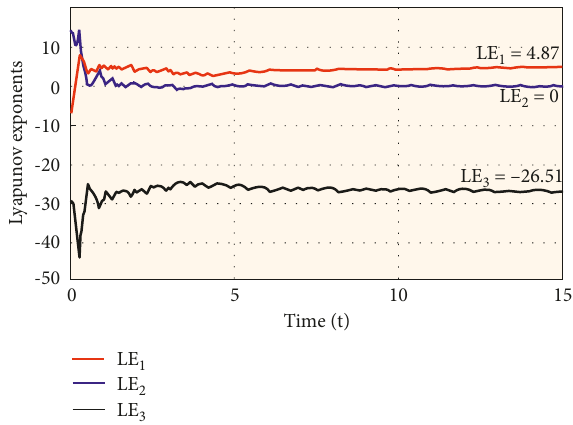
Figure 5: Lyapunov exponents of system